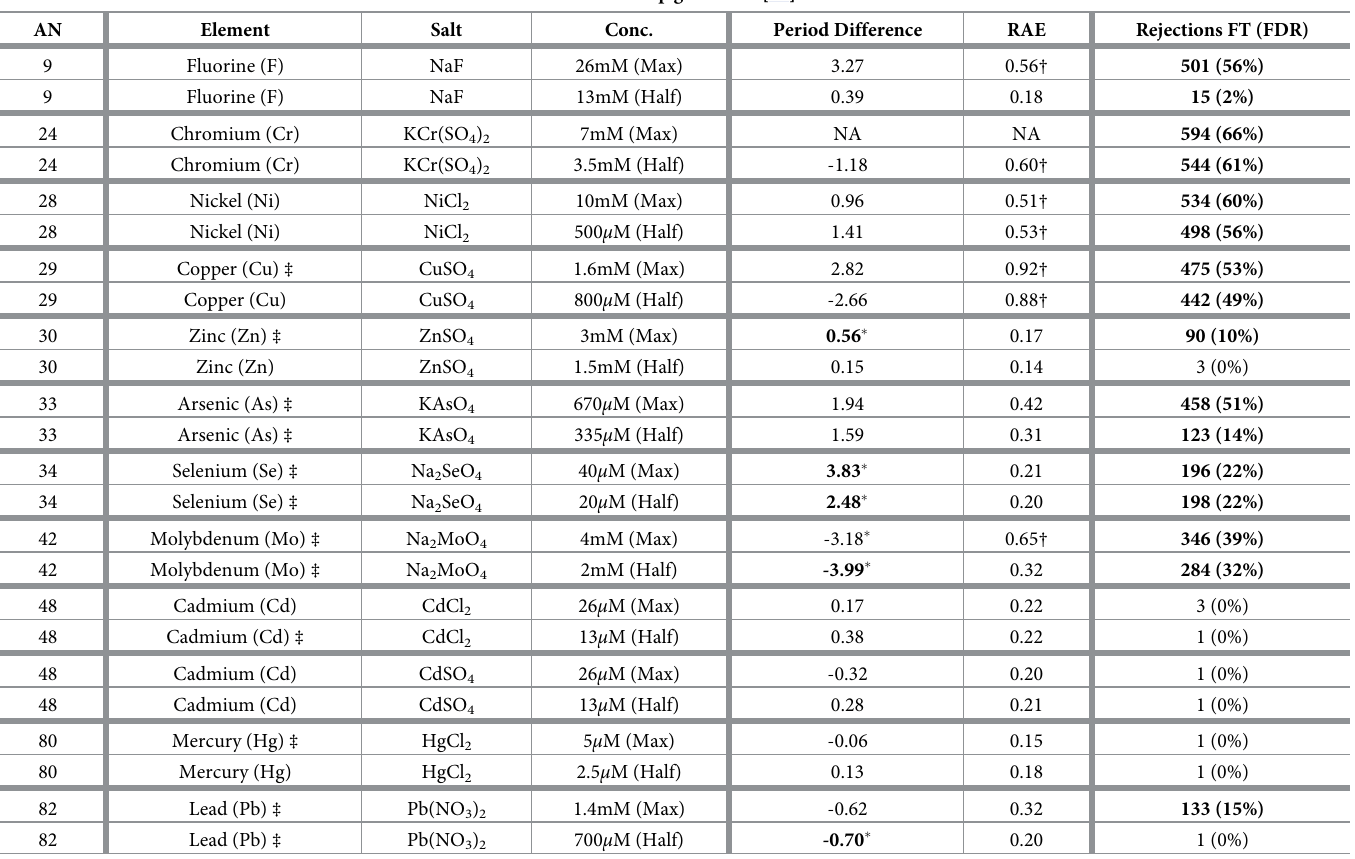
Table 1. Chemical treatments: Elements described in the DEFRA/YARA/Lancrop guidelines